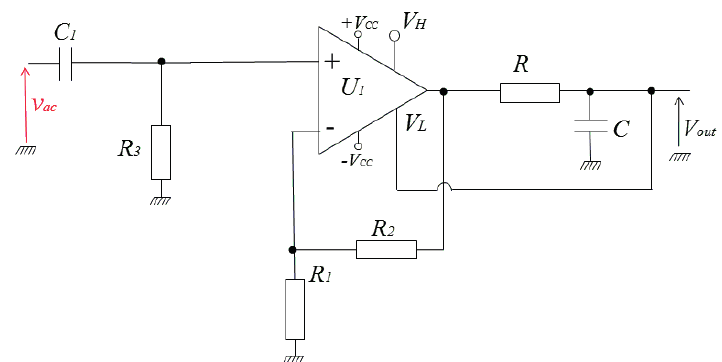
Figure 4. Amplitude detection of the rectified output. The mean value of the output, obtained by a low pass RC filter, is re-injected into the low-level limiter V L . U 1 : OPA699, C 1 = 100 nF,